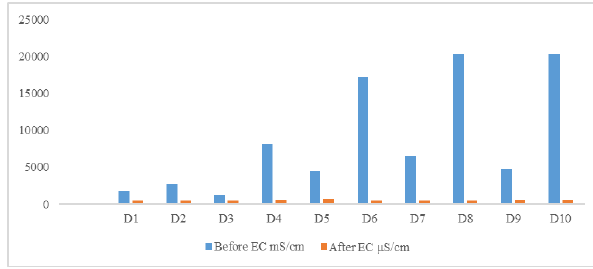
Fig. 8. EC of Samples before and after Treatment, Diplo City